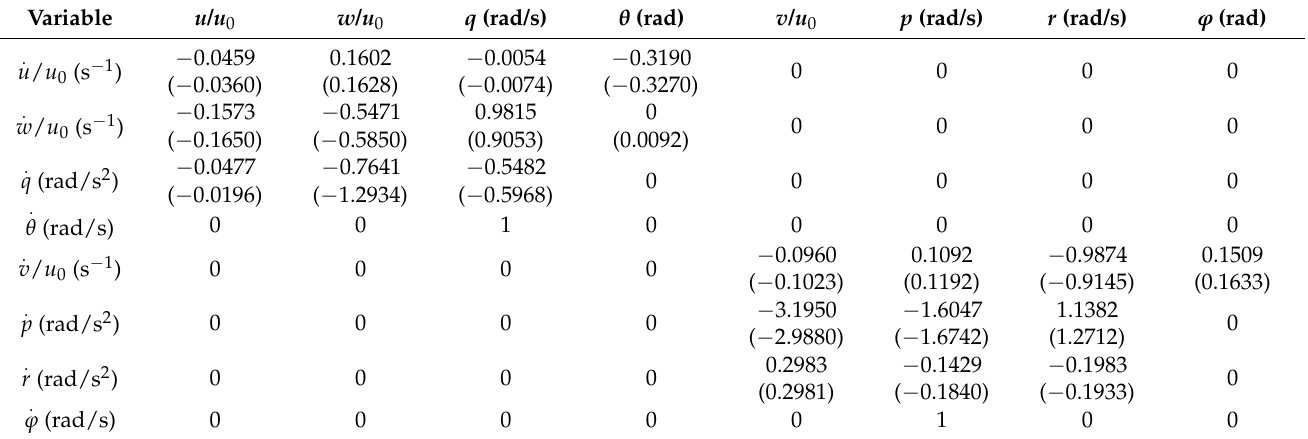
Table 18. CFD–RANS (extrapolated) 8 × 8 stability matrix for flight condition 11 in Tables 4 and 5.